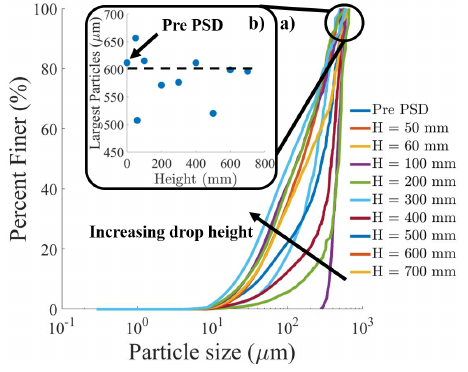
Figure 2. (a) PSD at varying heights, (b) largest particle from each sample plotted vs drop